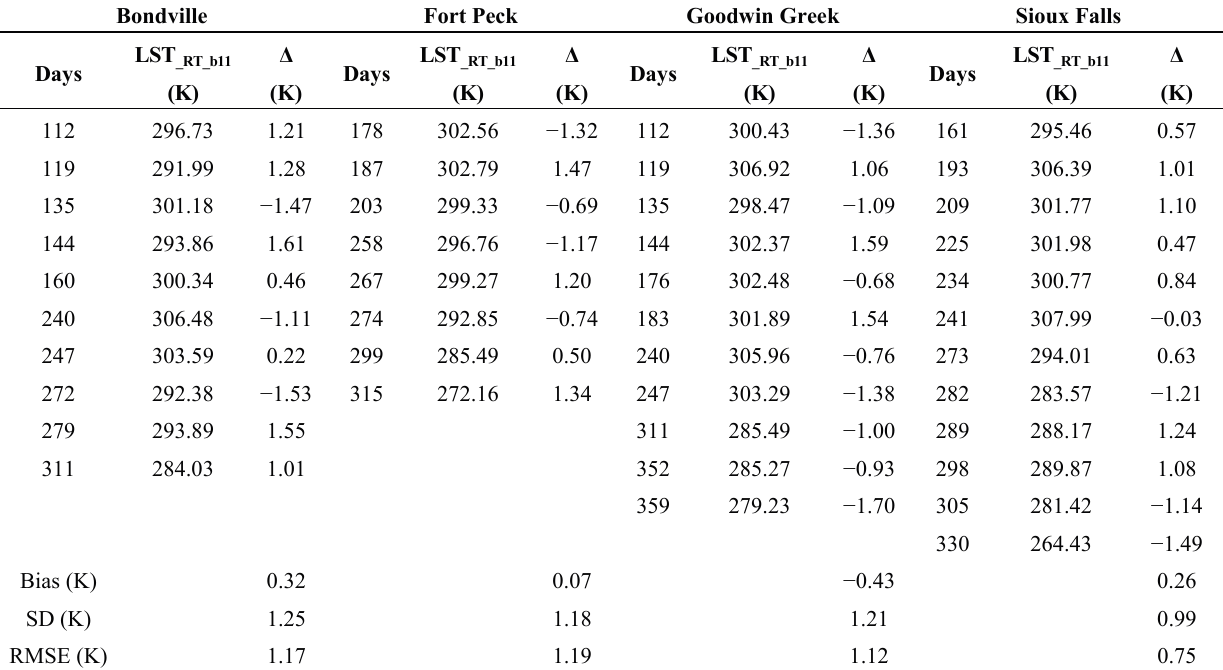
) using radiative transfer equation-based method from _RT_b11 and LST for four selected _RT_b11 _g